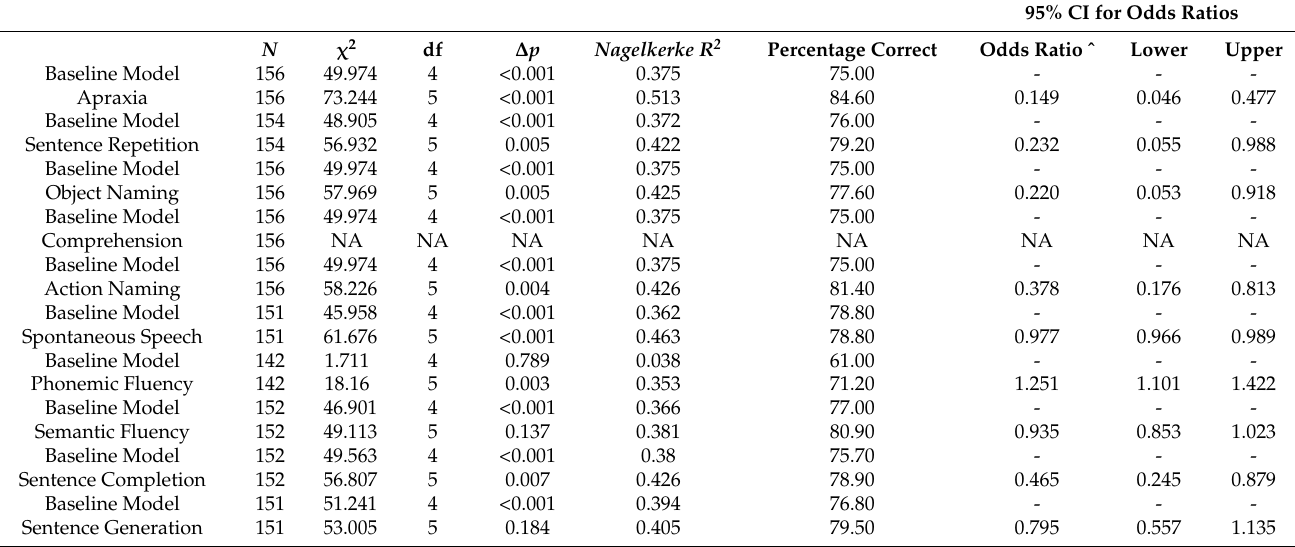
Table 5. Logistic regression for discriminating between the Healthy and Stroke